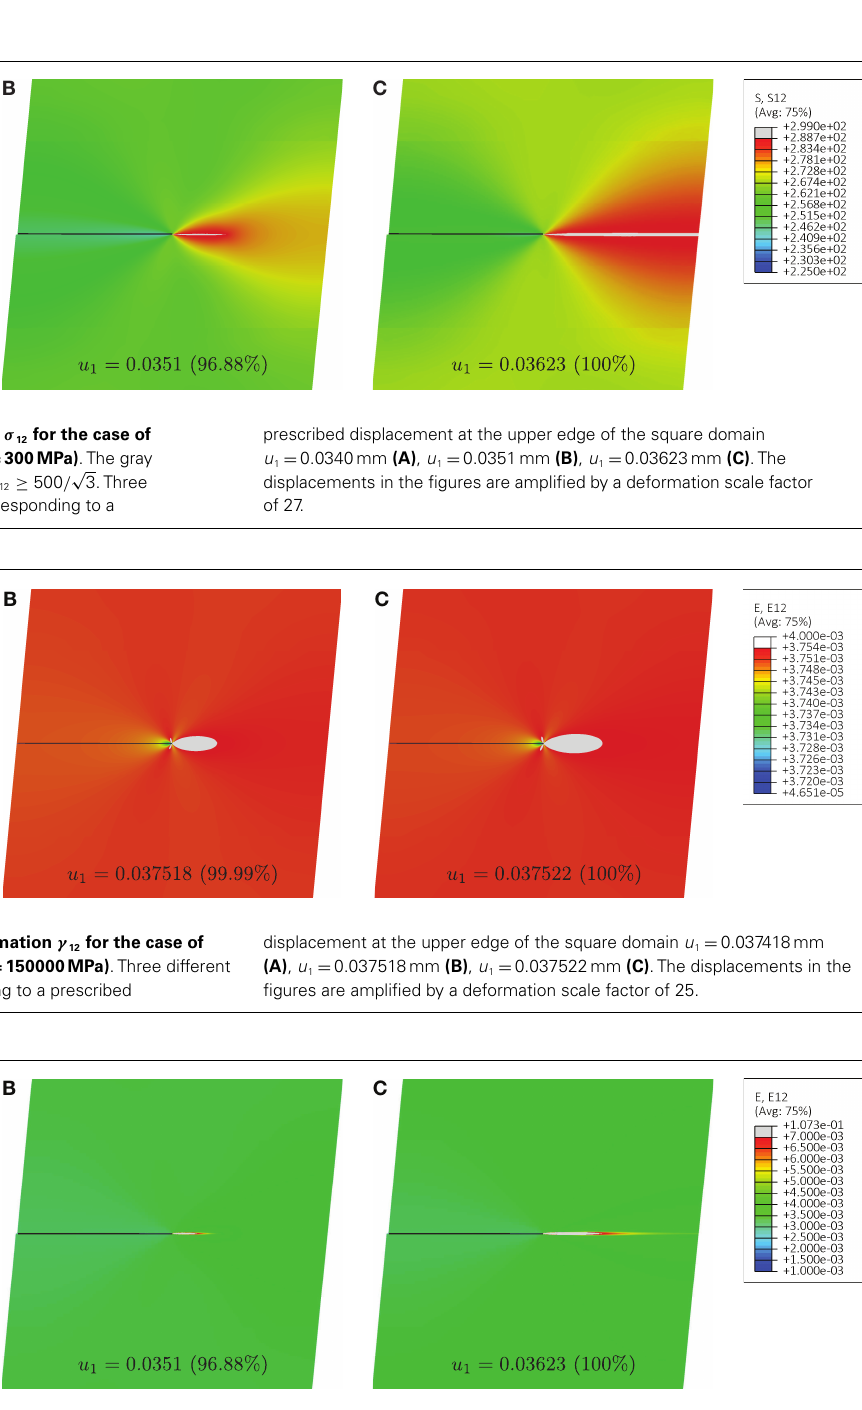
displacement at the upper edge of the square domain u 1 = 0.0340mm (A) , u 1 = 0.0351mm (B) , u 1 = 0.03623mm (C) .The displacements in the figures are amplified by a deformation scale factor of 27.